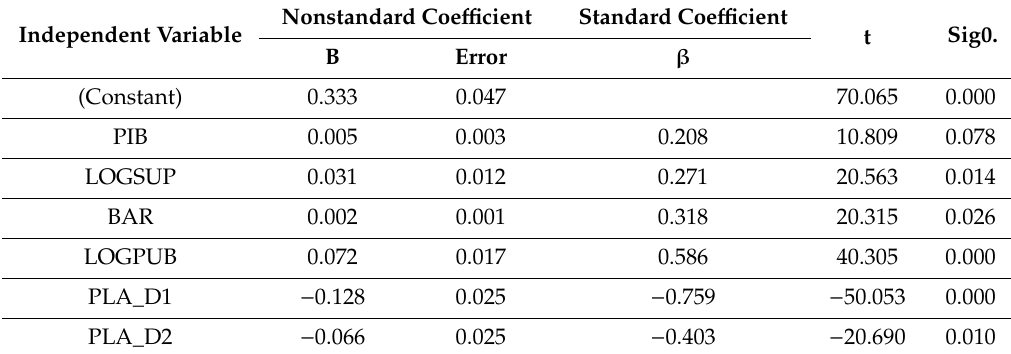
Table 7. MLR model for dependent variable GIN.